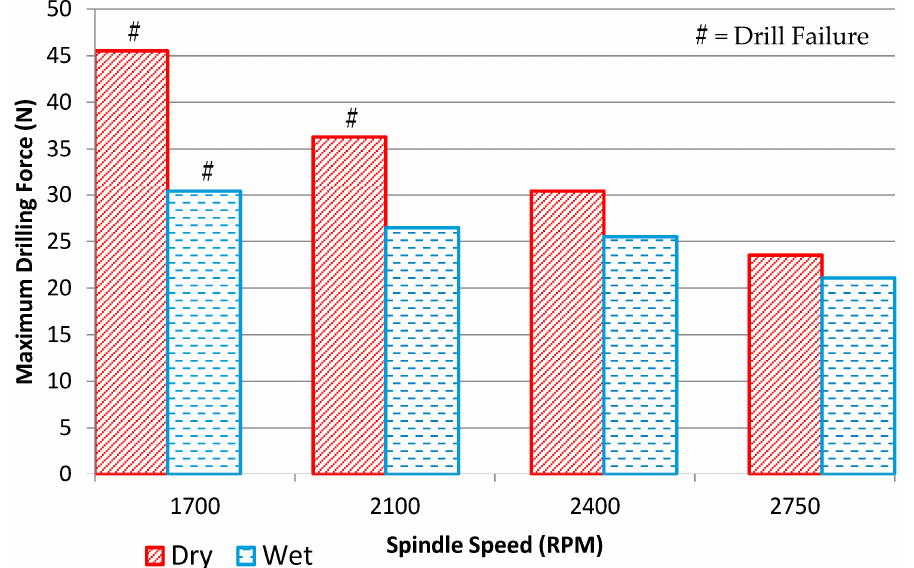
Figure 6. Maximum drilling force.